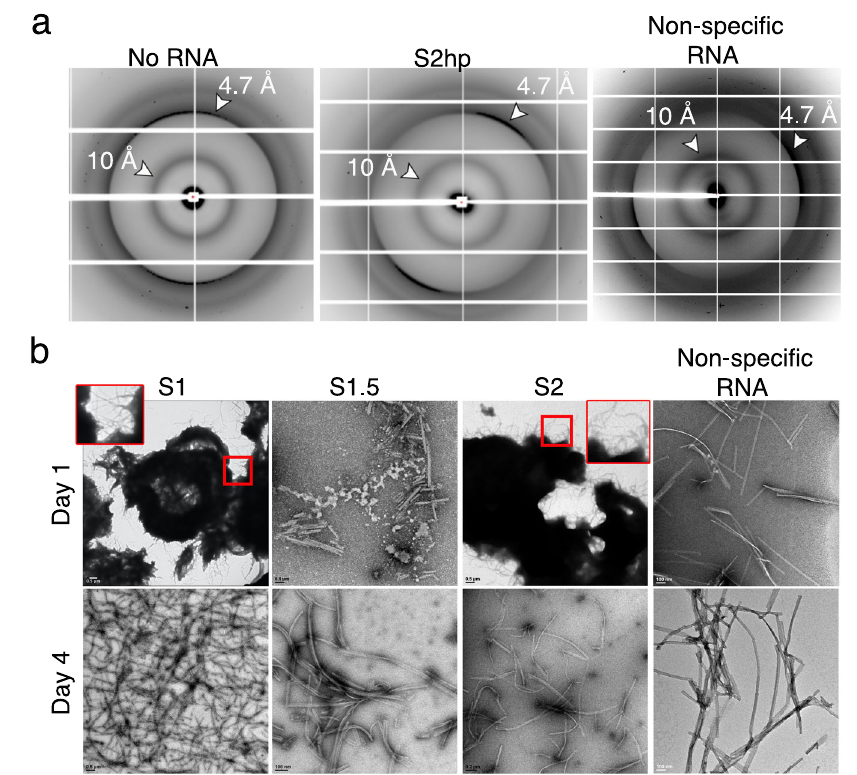
Fig. 2 | The central LCD segment of NCAP demonstrates amyloid-like char- acteristics.a X-ray diffractionsofLCD-only fi brils (No RNA), andLCD fi brilsgrown with hairpin-Site2 (S2hp) vRNA or non-speci fi c RNA (antisense siDGCR8-1), show amyloid-characteristic 4.7 and 10Å re fl ections labeled by white arrows. b Negative stain EM micrographs of LCD fi brils grown in the presence of the short vRNA segments Site1 (S1; 11 nucleotides), Site 1.5 (S1.5; 22 nucleotides) and Site2 (S2; 22